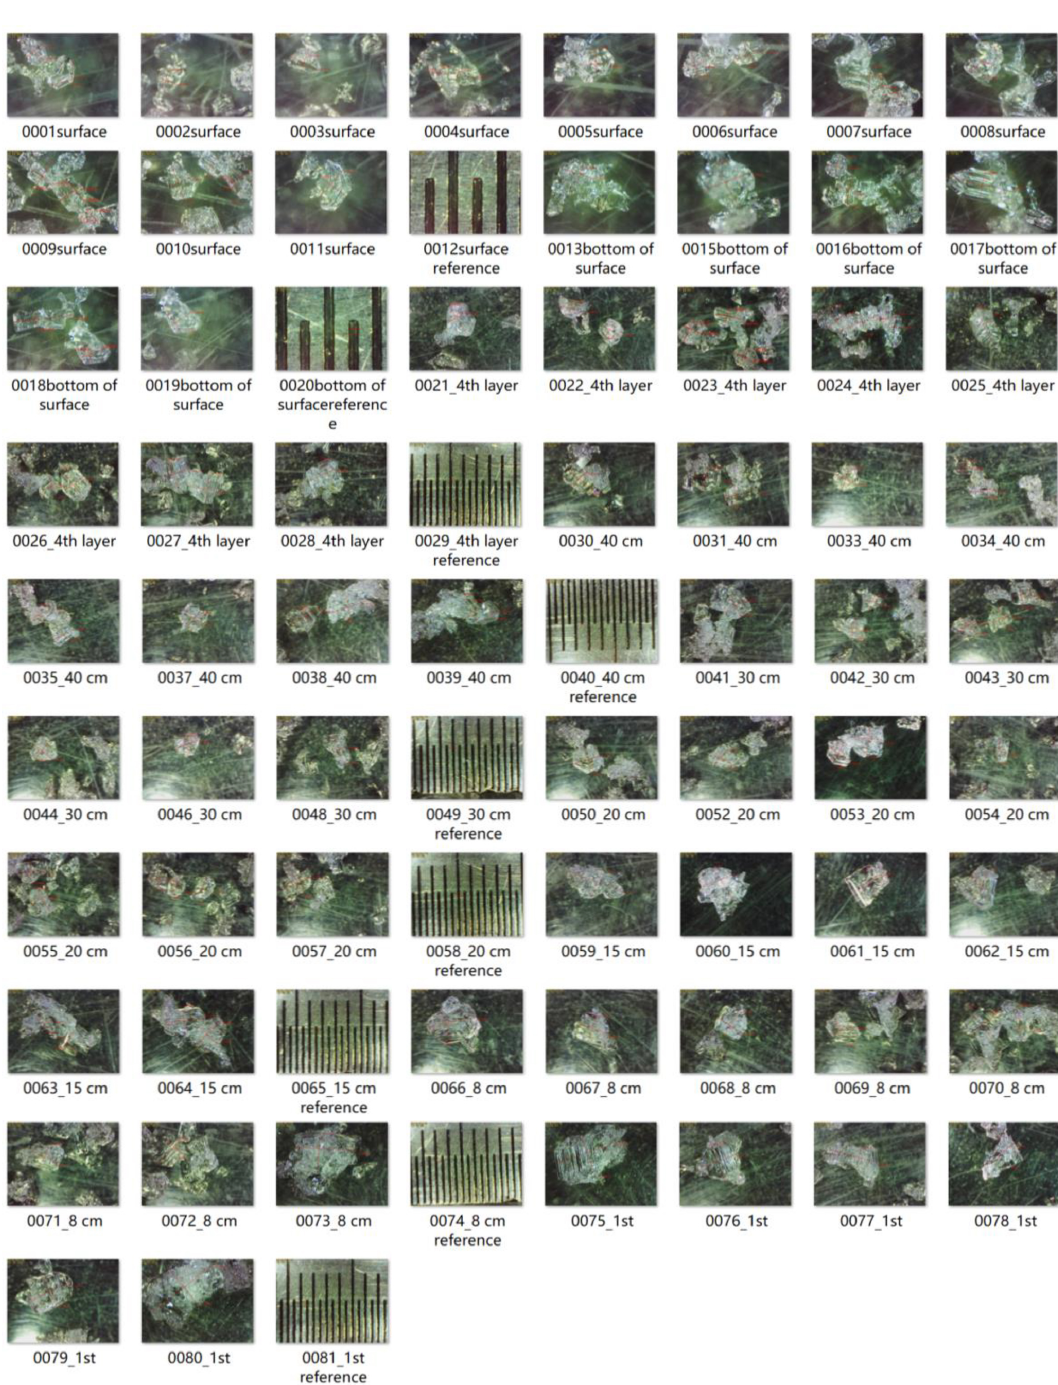
Earth Syst. Sci. Data, 14, 3509–3530,